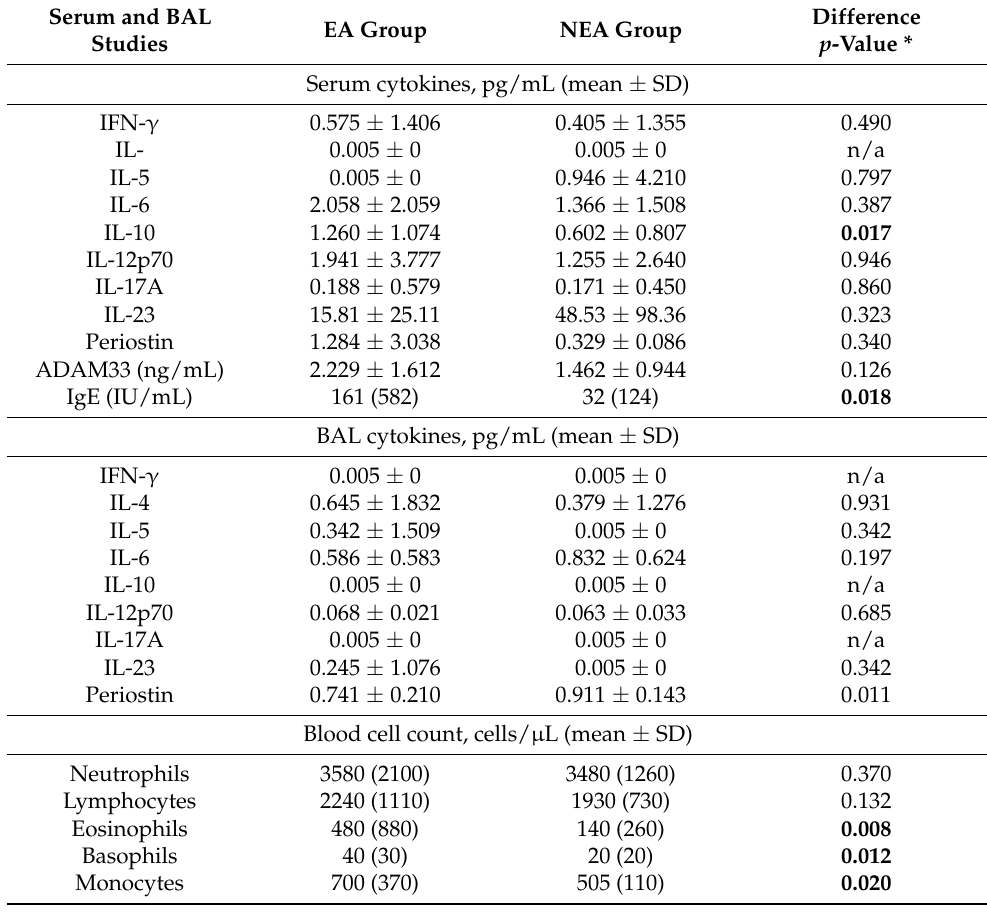
Table 3. Immune mediators in serum and bronchoalveolar lavage fluid. Serum and